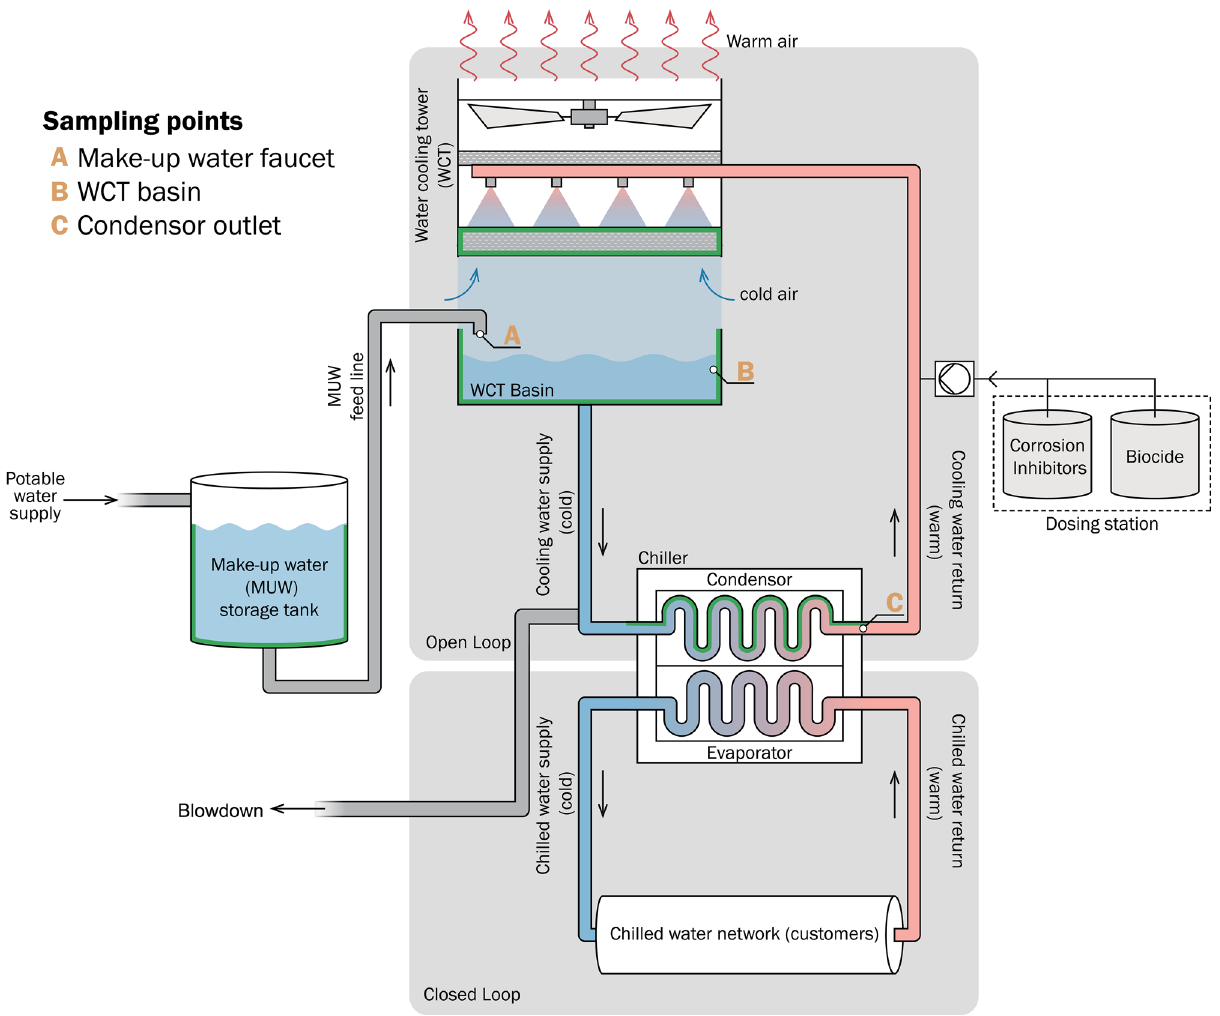
Figure 1. Simplified schematic of a DCP, indicating the positions of where water samples containing planktonic populations were collected for this study. Potable water feeds the make-up water (MUW) tank which, in turn, supplies the system with cooling water via the water-cooling tower (WCT) basins. Cooling water enters the chiller condenser where it is heated in condenser tubing via thermal exchange with the refrigerant that cools the chilled water returning from the customer network. Warm cooling water exits the condenser and is pumped to the WCTs where it is cooled by evaporative action. The sampled locations are: (A)—MUW faucet, (B)—Water cooling tower basins (WCT) and (C)—Condenser outlet water. Common fouling sites (MUW tank, WCT basin and condenser tubing) are highlighted in water pH, conductivity and oxidation–reduction potential (ORP) yielded significant differences in contrasts between YI and the other plants (with P < 0.001 in all cases) suggesting that the excessive water consumption at YI, stems from low quality water automatically triggering the blow down valves (which are controlled by on-site conductivity). Conductivity on site is only measured in cooling water loop and so measures for sites A, B and C were taken in the lab (Supplementary Table 1). Conductivity values in lab and on-site datasets were generally similar but lab readings were higher for KC, indicating a possible probe issue at site. TIC loads were measured as a proxy for carbonate (a common component of mineral scales), and were highest in plant RB (mean of 72.089 ± 40.736 ppm), with P < 0.001 versus each of the other plants, suggesting that scaling was responsible for reducing RB plant performance. Whereas TOC remained low throughout the study (0–23.2 ppm across the plants). Chemical parameterization of the MUW entering the three plants shows that the water entering the system is consistently of high quality (Supplementary Fig. S1 and Fig. 2b). Samples collected from within the open loop of the three plants showed a consistent decrease in water quality from A (MUW) to B (WCT basins) or C (condenser outlets), with 4 ions (Ca, Cl, K and Na), conductivity, TIC and TOC increasing significantly ( P < 0.001 in all cases) in all study plants. Of the 13 ions tested, 6 (Ca, Cl, K, Mg, Na, NO 3 and SO 4 ) comprised the bulk of ionic contaminants, with calcium being the most abundant. In agreement with the TIC levels, RB had the highest concentration of calcium, which suggests calcium carbonate, a common scaling agent 18 is probably the main scaling agent in this system.